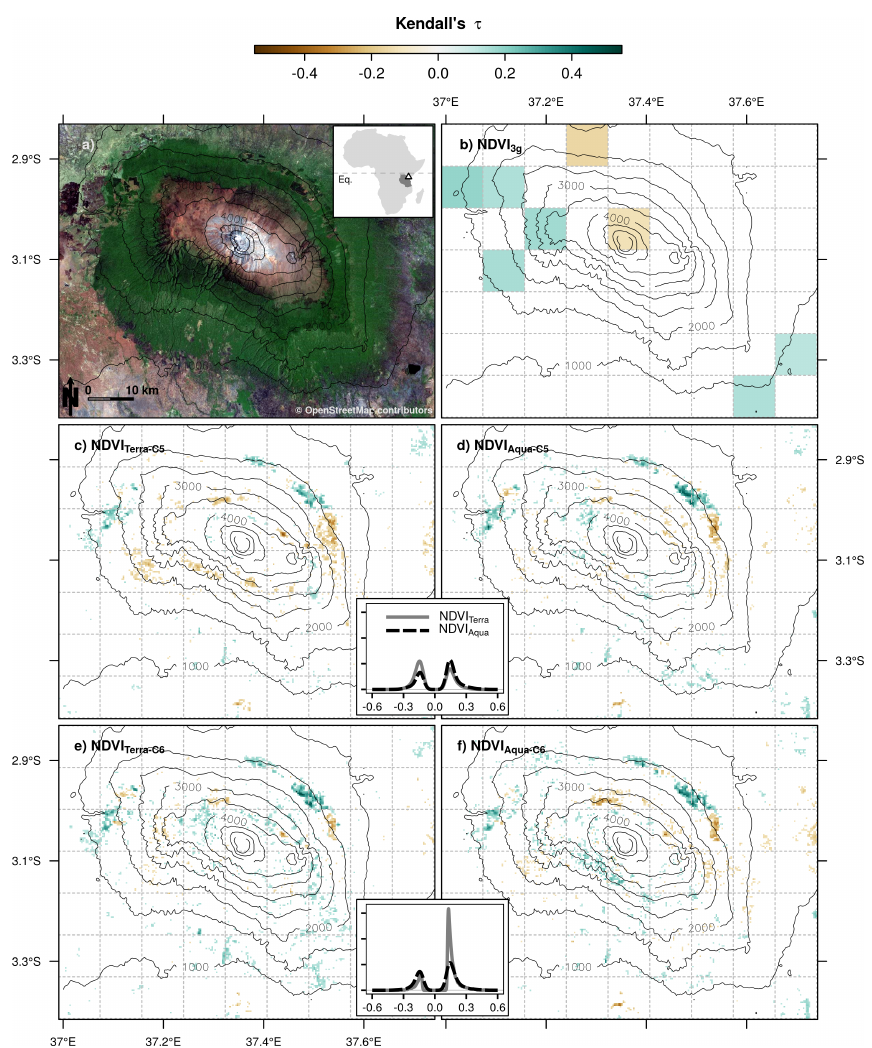
Figure 2. ( a ) Bing Maps aerial image of the study area (downloaded via OpenStreetMap [49]); spatial patterns of “significant” values of τ (2003–2012) for ( b ) NDVI 3g ; ( c ) NDVI Terra-C5 ; ( d ) NDVI Aqua-C5 ; ( e ) NDVI Terra-C6 ; and ( f ) NDVI Aqua-C6 . Also included are the 1-d Kernel density estimates for the 250-m MODIS products originating from Collections 5 (connecting c and d ) and 6 (connecting e and f ). The underlying CRS and additional data are the same as in Figure